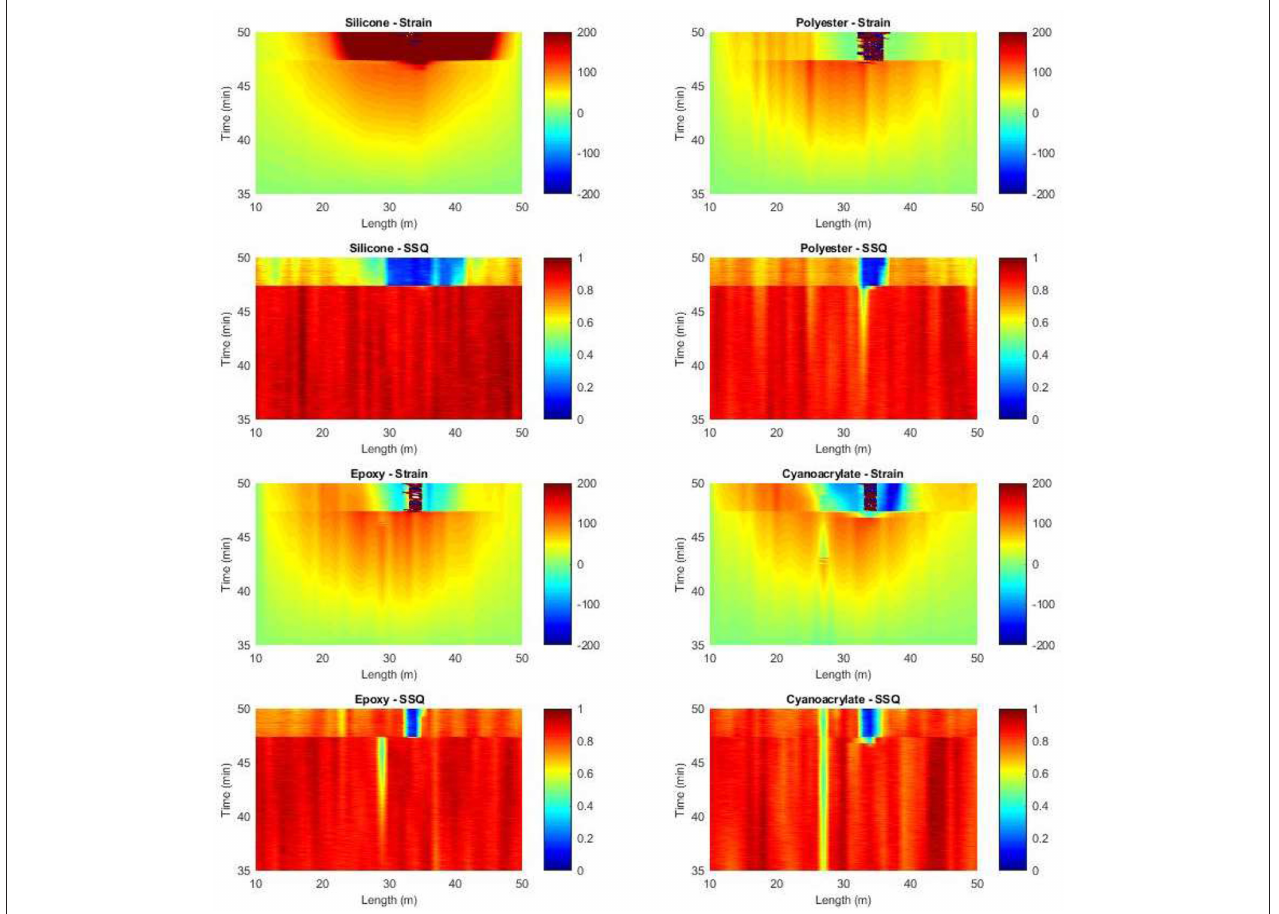
FIGURE 11 | Measured strain and corresponding SSQ values for each bonded segment between minute 35 and 50.